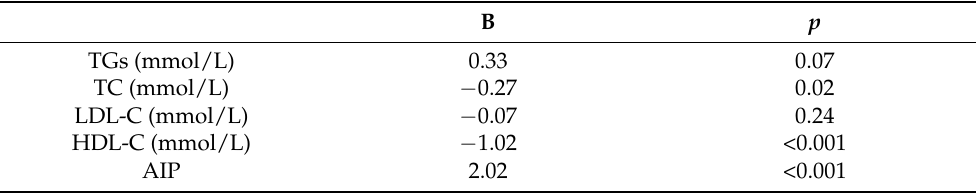
Table 2. The relationship between lipidic fractions and